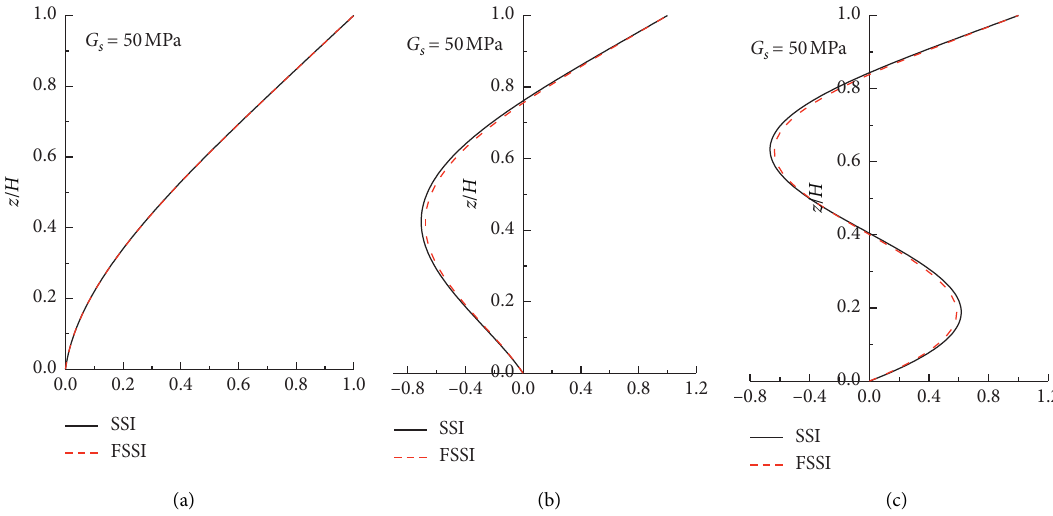
� 0.1, δ � 0, and c � 0.5: (a) first, (b) second, and 0 0 0